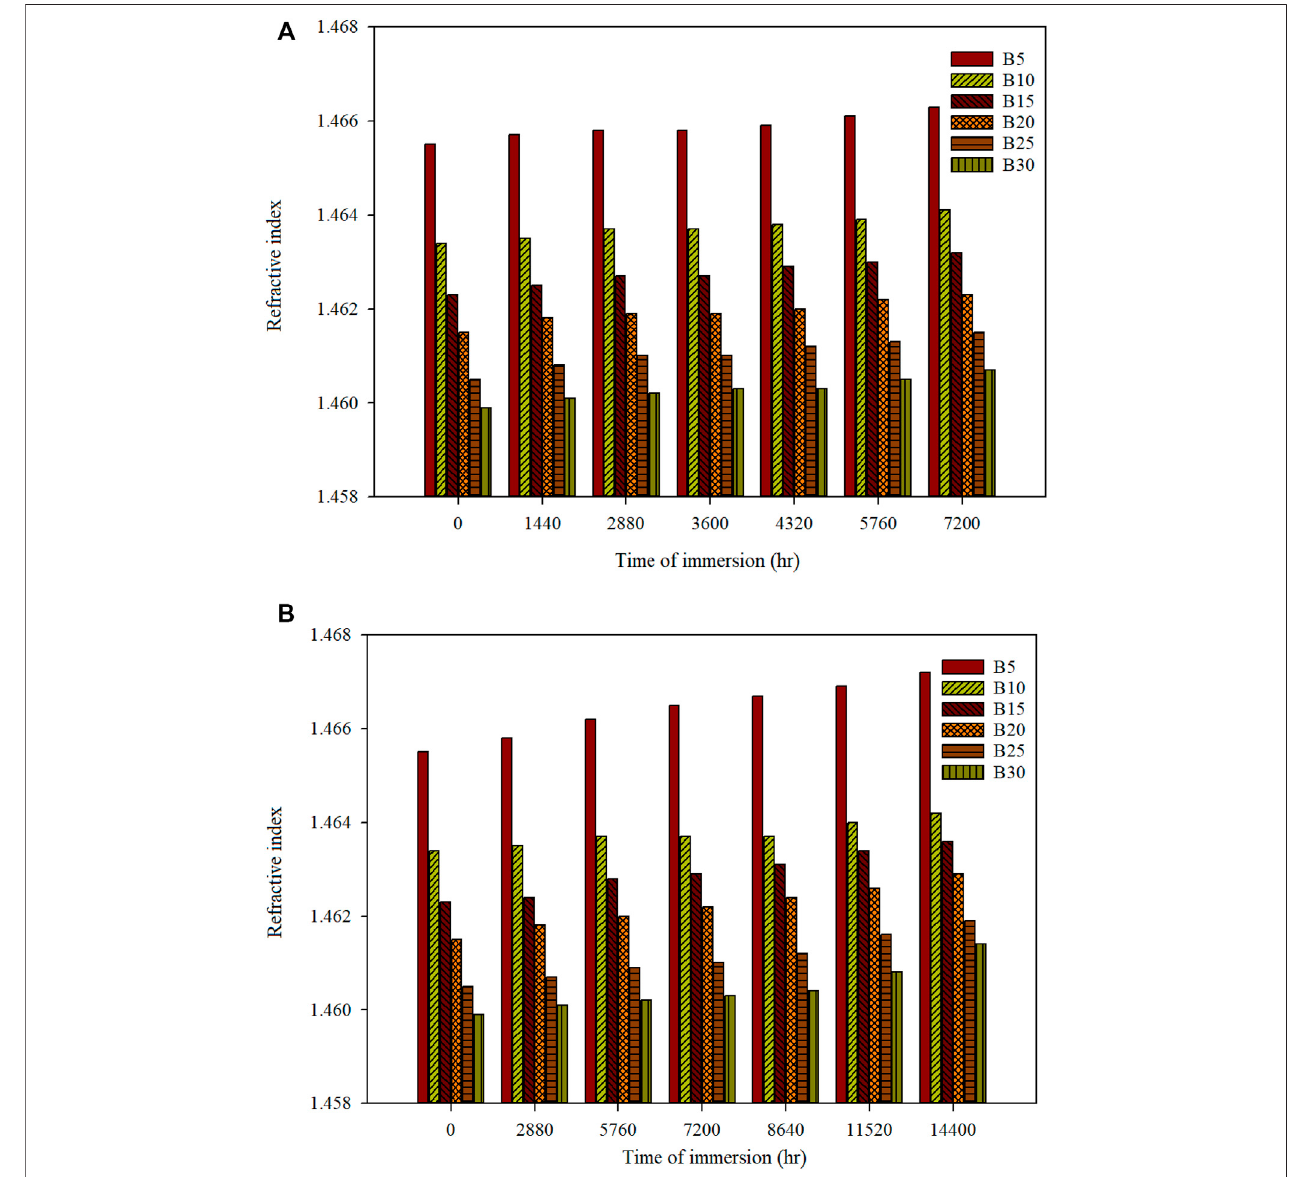
FIGURE 6 | Refractive index of different biodiesel-diesel blending ratios for (A) mild steel and (B) stainless steel 316 for a speci fi c time of immersion.